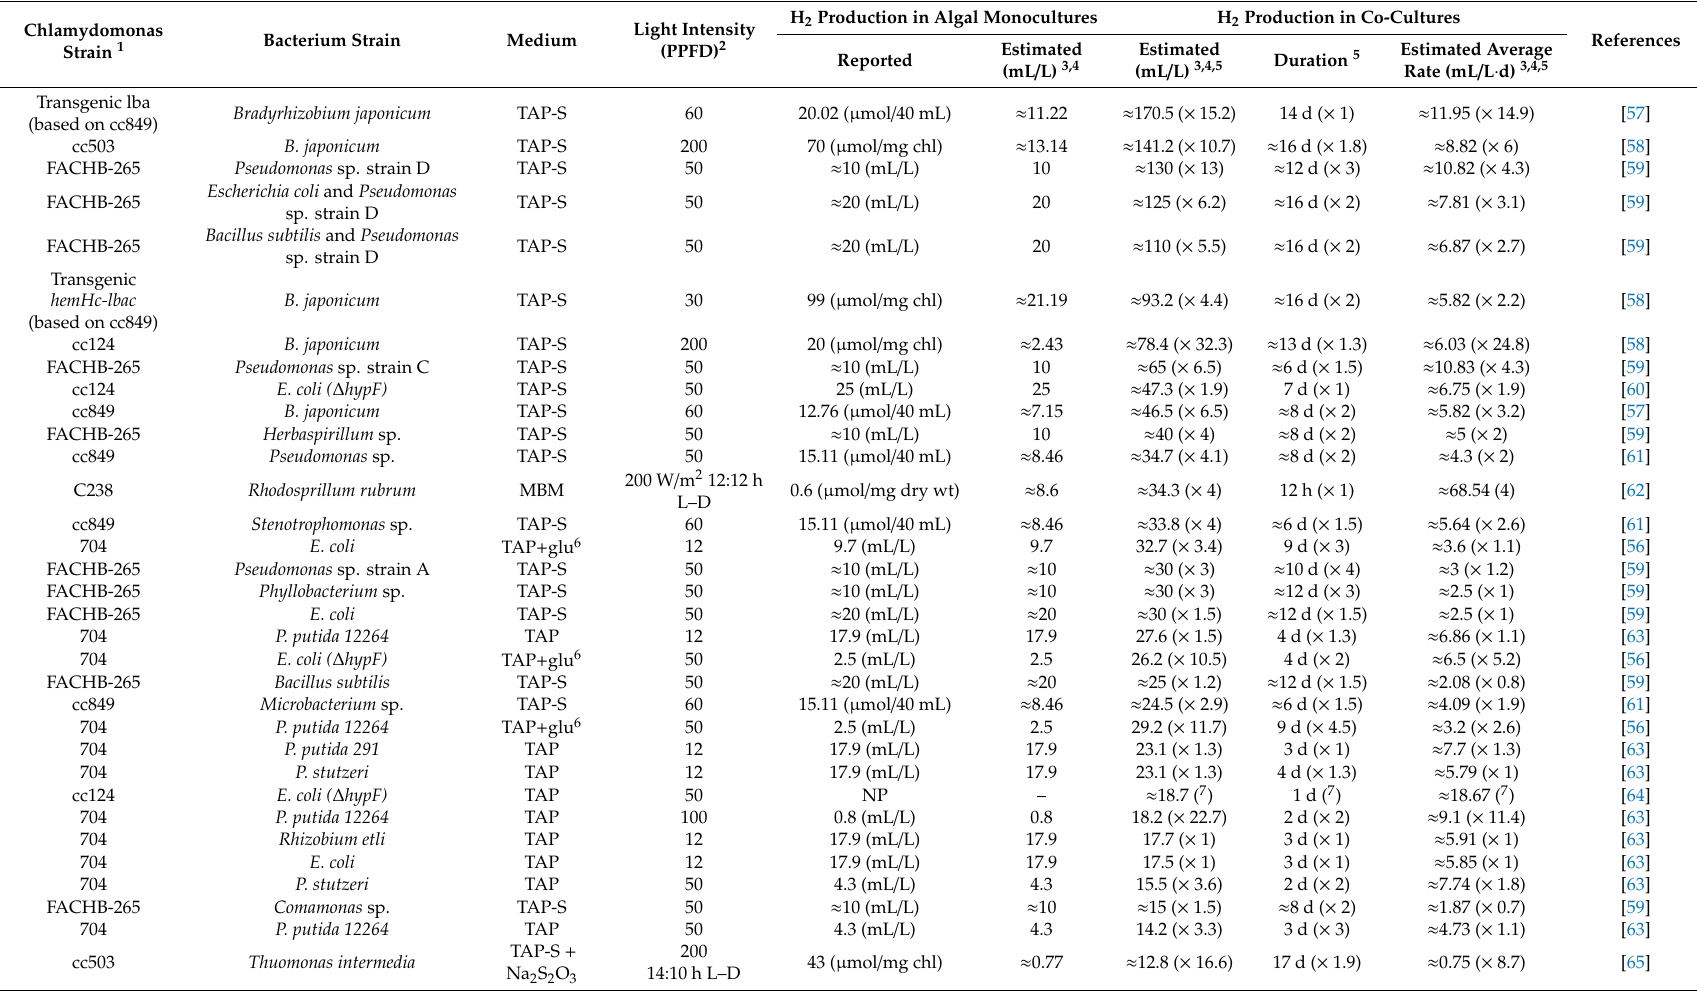
Table 1. Comparison of yield, rate and sustainability of H 2 generation in Chlamydomonas–bacteria co-cultures versus alga monocultures. For each report, only data from co-cultures with their corresponding control monocultures are considered (when possible). Data are ranked according to the total H 2 production in